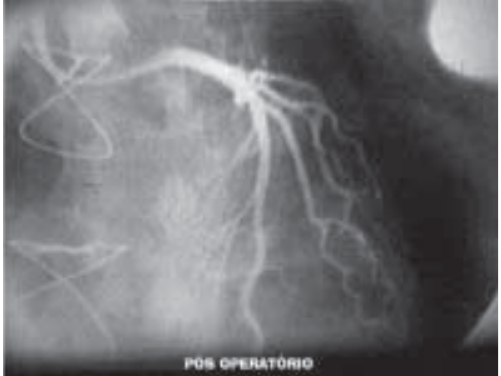
Fig. 2B - Post-operative angiography of the left coronary artery fistula to the pulmonary branch.